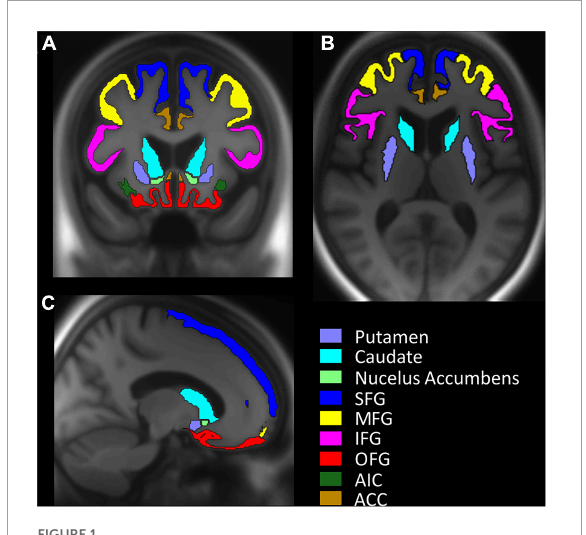
FIGURE1 Visualization of gray matter segmentation for each region of interest (ROI). (A) Coronal plane. (B) Horizontal plane. (C) Sagittal plane. SFG, Superior frontal gyrus; MGF, middle frontal gyrus; IFG, inferior frontal gyrus; OFG, orbitofrontal gyrus; AIC, anterior insular cortex; ACC, anterior cingulate cortex.